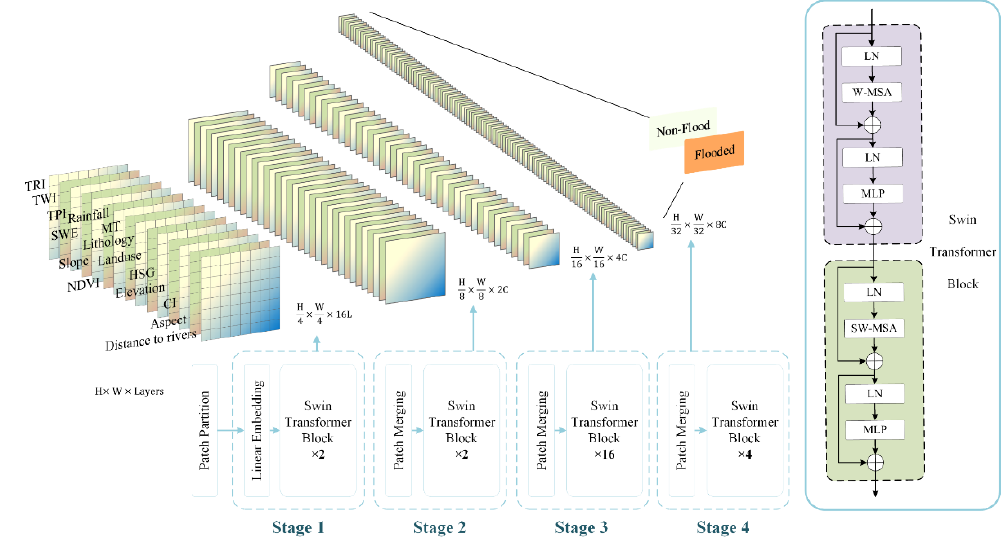
Figure 4. Swin Transformer structure.